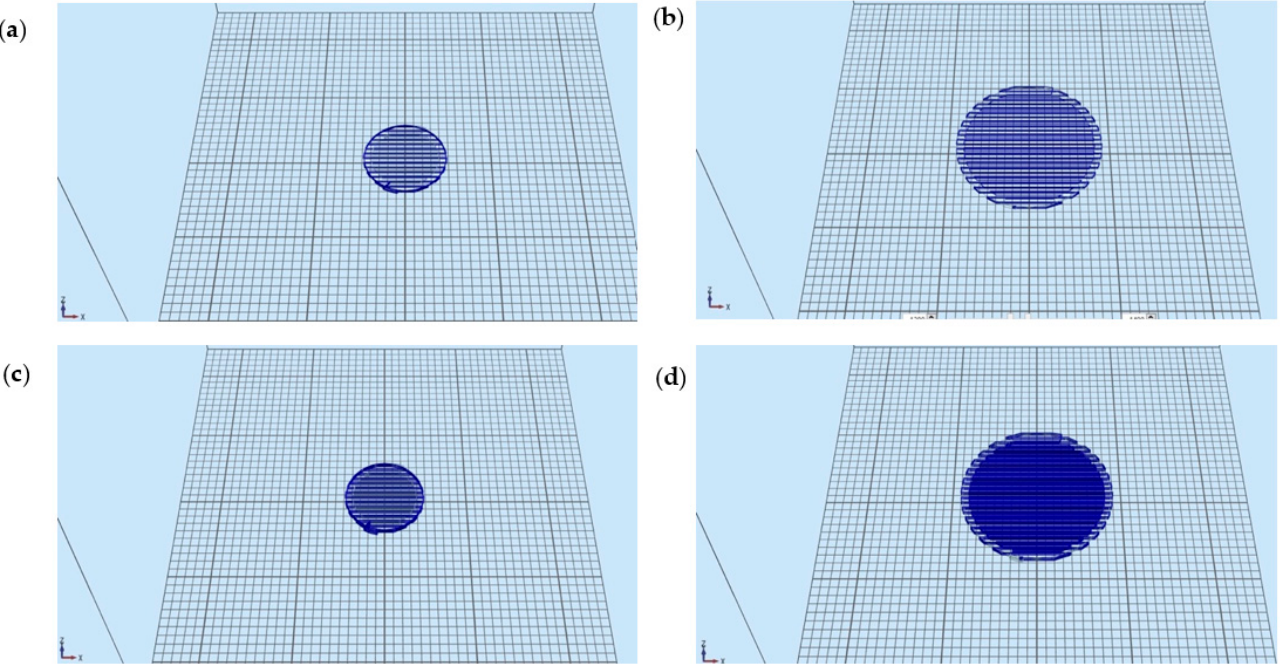
Figure 1. CAD file representing rectilinear infill pattern: ( a , c ) dome-shaped (~10 mm in diameter); ( b , d ) disc-shaped (~30 mm in diameter).